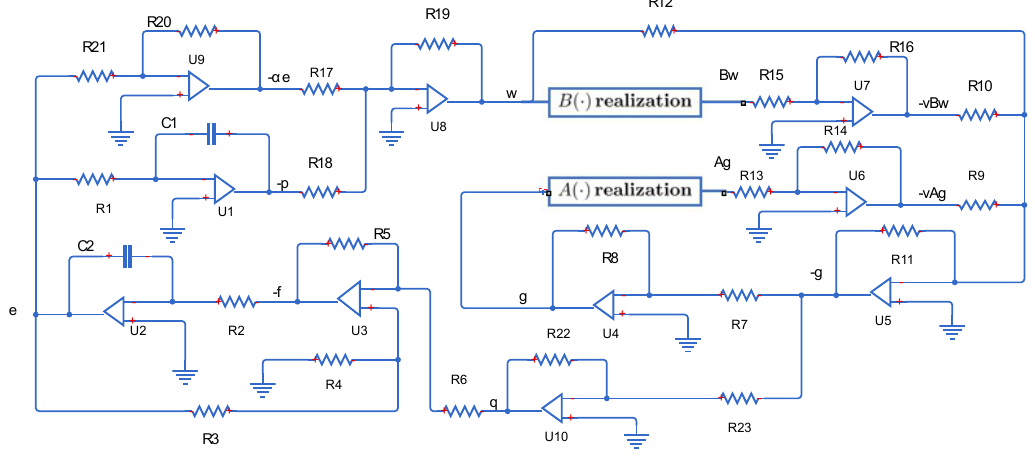
Figure 1. Circuit architecture diagram of model (42), where e = ˙ p , f = ¨ p , w = p + α ˙ p , q = ˙ p + ¨ p , g = q / k